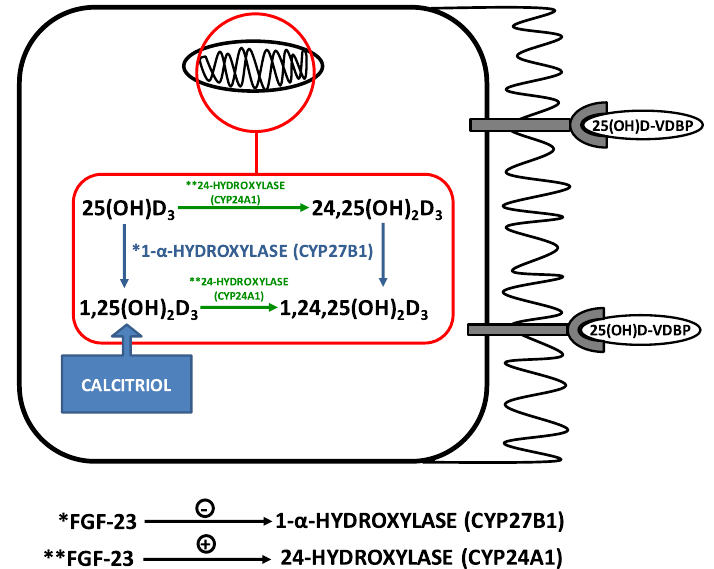
Figure 2. Regulation of Vitamin D metabolism by FGF-23. The megabin-cubilin receptors on the brush border of proximal tubules uptake the complex 25(OH)D-VDBP in an endocytosis-mediated process. In mitochondria, 25(OH)D 3 is converted to the active form 1,25(OH) 2 D 3 by 1-alpha-hydroxylase. FGF-23 inhibits 1-alpha-hydroxylase and stimulates 24-hydroxylase, which degrades both 25(OH)D 3 and 1,25(OH) 2 D 3 to 24,25(OH) 2 D 3 and 1,24,25(OH) 2 D 3 , respectively. Note: *action of 1-alpha-hydroxylase (CYP27B1); ** action of 24-hydroxylase (CYP24A1).